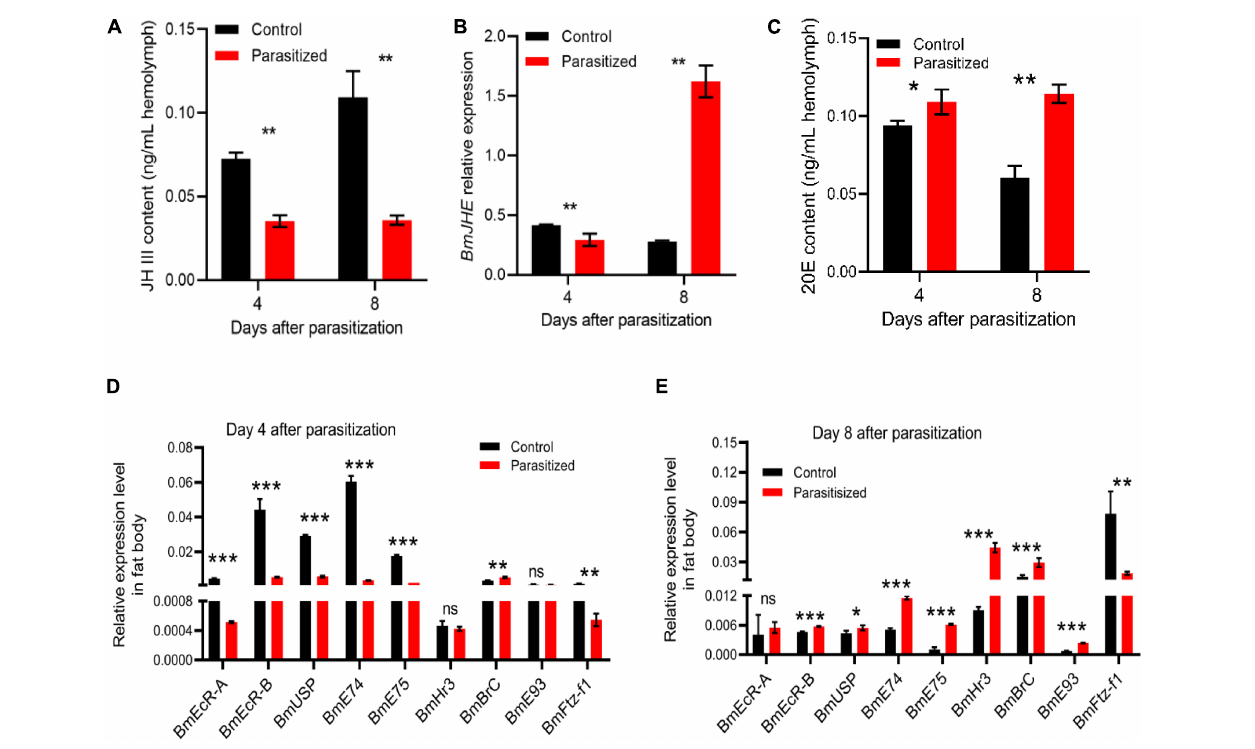
FIGURE 3 | Detection of juvenile hormone (JH) and 20-hydroxyecdysone (20E) titers and the transcription of their responsive genes. (A) JH III titers in the hemolymph of silkworm larvae at 4 (silkworms at wandering stage) and 8 (silkworm at prepupal stage) DAP. (B) The expression level of BmJHE in the fat body relative to BmActin3 . (C) 20E titer in the hemolymph of silkworm larvae at 4 and 8 DAP. (D) The expression levels of 20E-responsive genes relative to BmActin3 in the fat body of silkworms at 4 DAP. (E) The expression levels of 20E-responsive genes relative to BmActin3 in the fat body of silkworms at 8 DAP. All the data were presented as mean ± SD with n = 3. Significance of the results was determined by the Student’s t -test; * P < 0.05, ** P < 0.01, *** P < 0.001, ns not